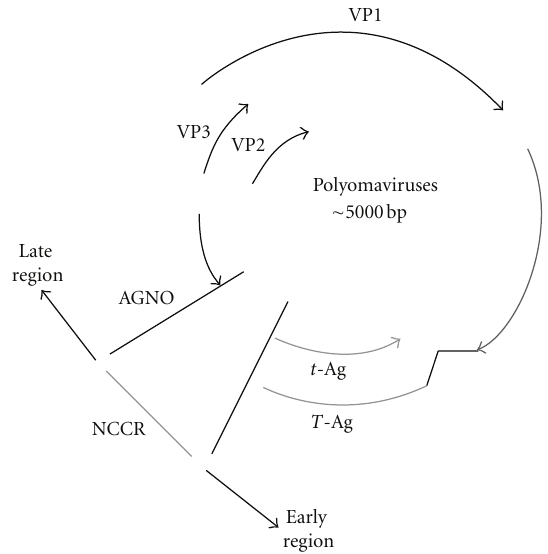
Figure 1: Schematic representation of the polyomaviruses genome organization. The circular double-stranded DNA genome is length about 5kb. The early region encodes the functional proteins LTAg and small T-Antigen, while the late region encodes the structural proteins VP1-3. The genome of JCV, BKV, and SV40 also encodes a small structural protein named Agno. The noncoding control region (NCCR) contains the origin of replication and regulates the replication and transcription of both the early and late